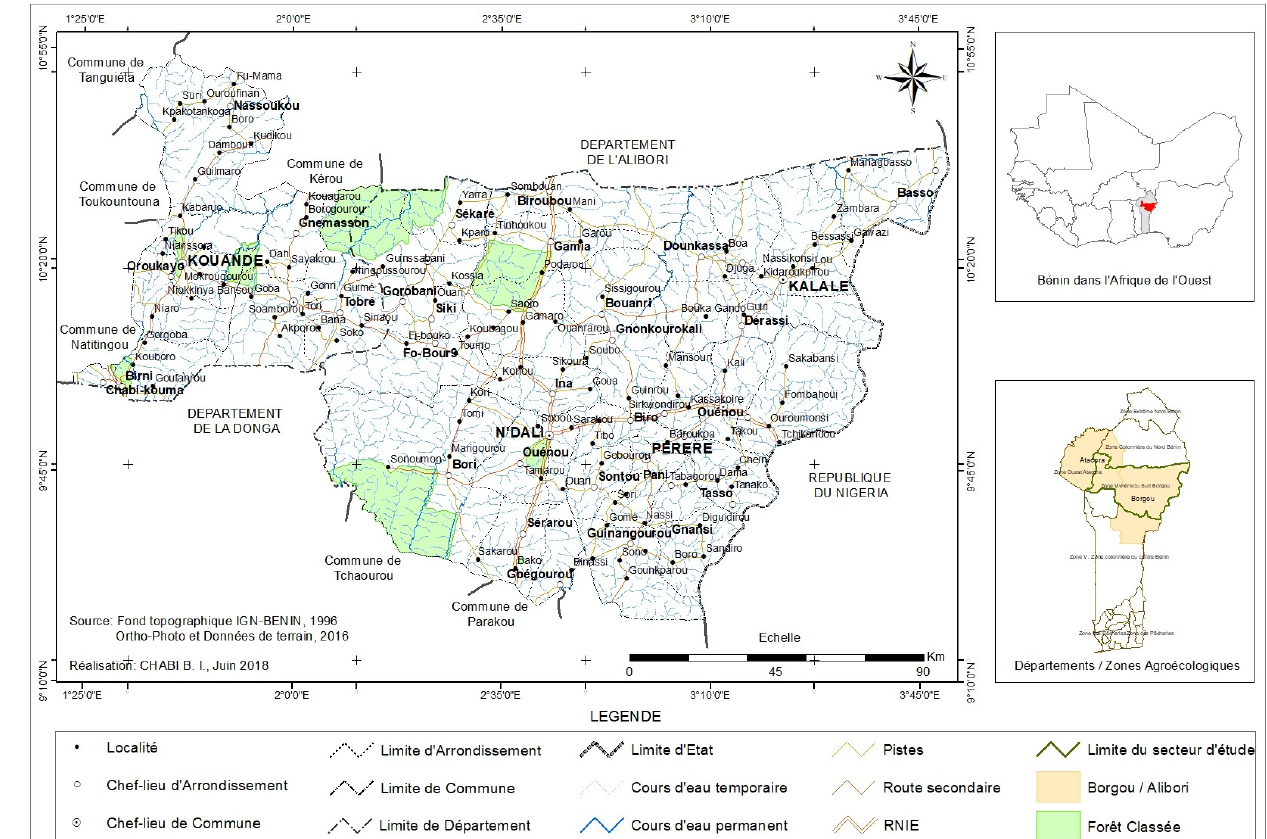
Figure 1. Situations géographique et administrative de la ZAE 3 du Bénin.